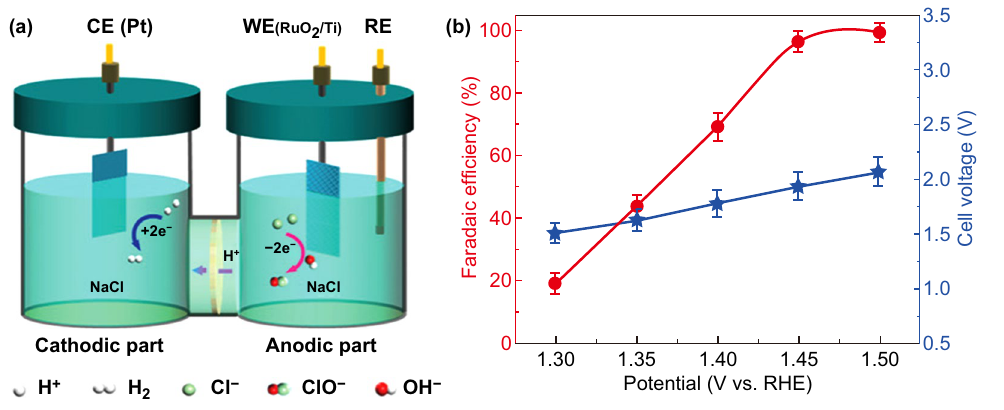
Fig. 7 a Schematic of the electrocatalytic cell for cathodic HER and anodic hypochlorite production, b dependence of the FE of hypochlorite with the applied potentials on the cathode and the cell voltage. Reproduced with permission from Ref. [97]. Copyright 2019 Royal Society of